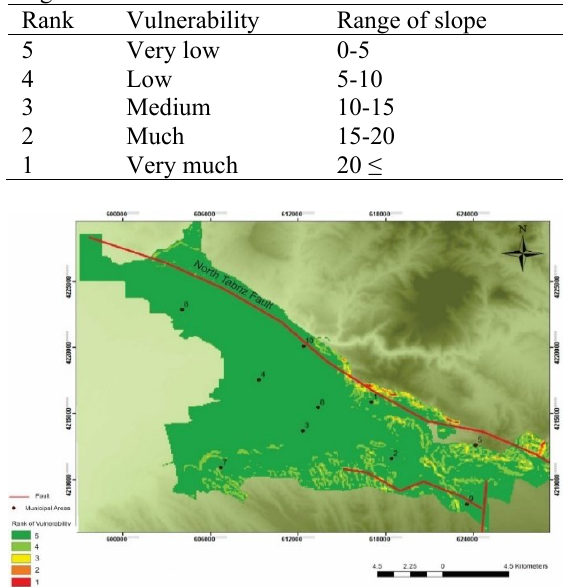
Table 3. Vulnerability and its ranking based on slope